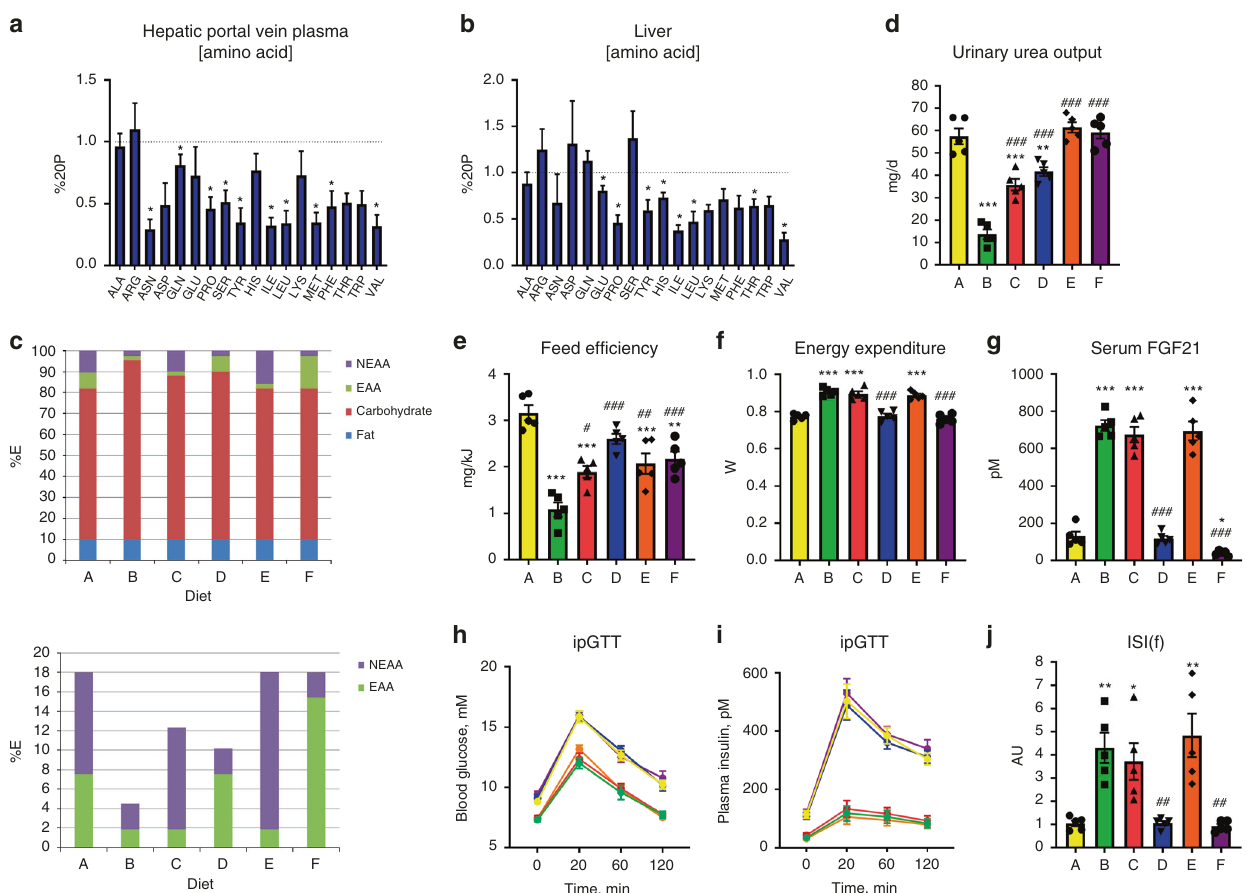
Fig. 2 Dietary essential amino acid restriction, independent from non-essential amino acid or carbohydrate supply, dictates the systemic metabolic response to dietary protein dilution. a Hepatic portal vein amino acid levels in response to refeeding a low-protein diet following a week of diet adaptation. Data (mean and SEM) are represented as a proportion of the control group fed a normal protein diet (20%P). n = 5/group derived from samples of individual mice. Data were analysed by Student ’ s t -test. Different than 20%P, * P < 0.05. b Liver tissue amino acid levels in response to refeeding a low- protein diet following a week of diet adaptation. Data are represented as a proportion of the control group fed a normal protein diet (20%P). n = 5/group derived from samples of individual mice. Data were analysed by Student ’ s t -test. Different than 20%P, * P < 0.05. c Nutrient source breakdown as % contribution to total energy for the experimental groups. EAA: essential amino acids. NEAA: non-essential amino acids. d Urinary urea output of mice in response to a 3-week treatment with diets as per the protocol of SF1A containing nutrient energy sources as in ( c ). Data are mean and SEM; n = 5 individual mice per group. Data were analysed by one-way ANOVA with Holm – Sidak post-hoc tests. Different than 20P: * P < 0.05, ** P < 0.01, *** P < 0.001. Different than 5P: # P < 0.05, ## P < 0.01, ### P < 0.001. e Feed ef fi ciency of mice as in ( d ). f Energy expenditure of mice as in ( d ). g Serum fi broblast growth factor 21 (FGF21) levels of mice as in ( d ). h Blood glucose levels during an intraperitoneal glucose tolerance test (ipGTT) of mice as in ( d ). i Plasma insulin levels during an intraperitoneal glucose tolerance test (ipGTT) of mice as in ( d ). j Insulin sensitivity index during fasting (ISI(f)) of mice as in ( d